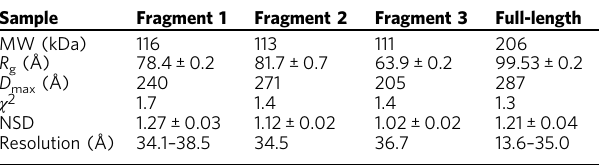
Table 3 Structural characteristics of Bvht fragments at 6 mM Mg 2 +